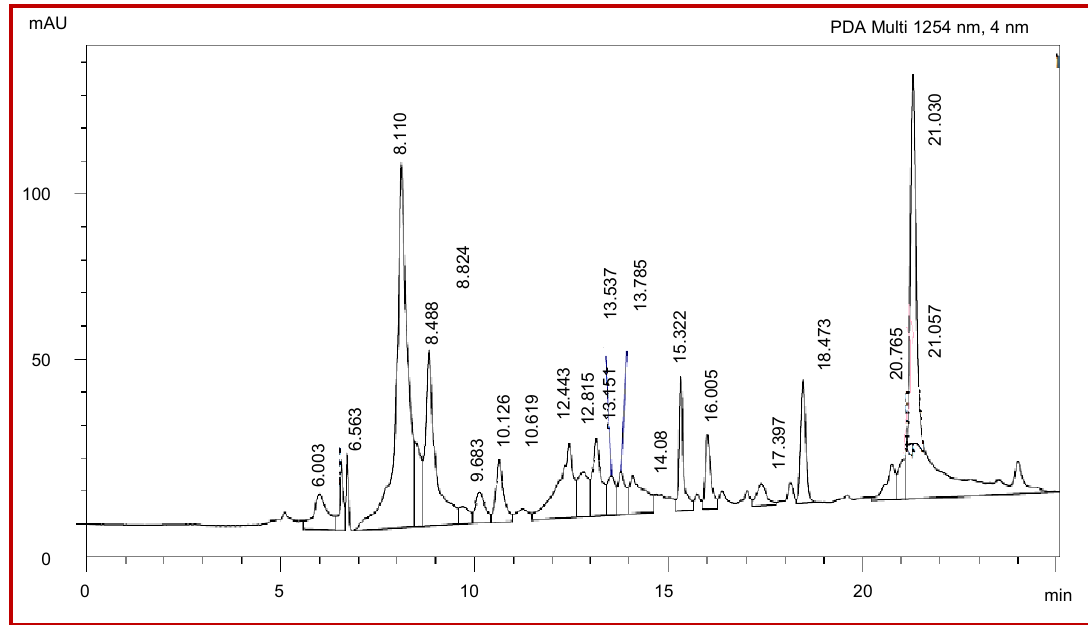
Figure 2: HPLC chromatogram of ethyl acetate extracted sample from